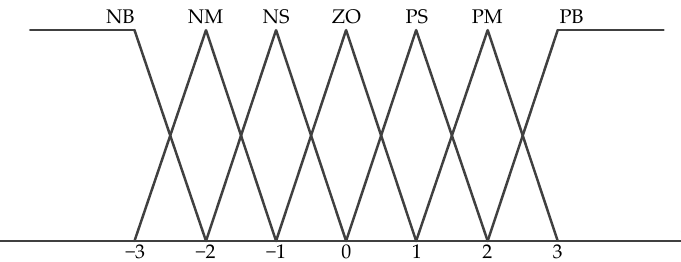
∆ K ∆ K p ( t ), and σ 1 i ( t ).